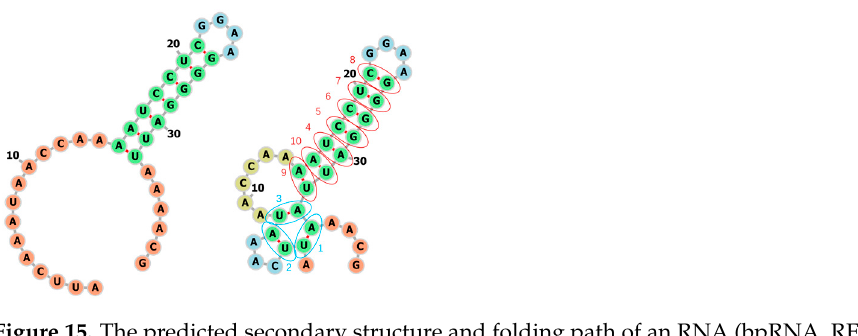
Figure 15. The predicted secondary structure and folding path of an RNA (bpRNA_RFAM_25409). The blue circle indicates the wrong prediction, the red indicates the correct prediction, and the numbers next to it indicate the order of formation (folding path).